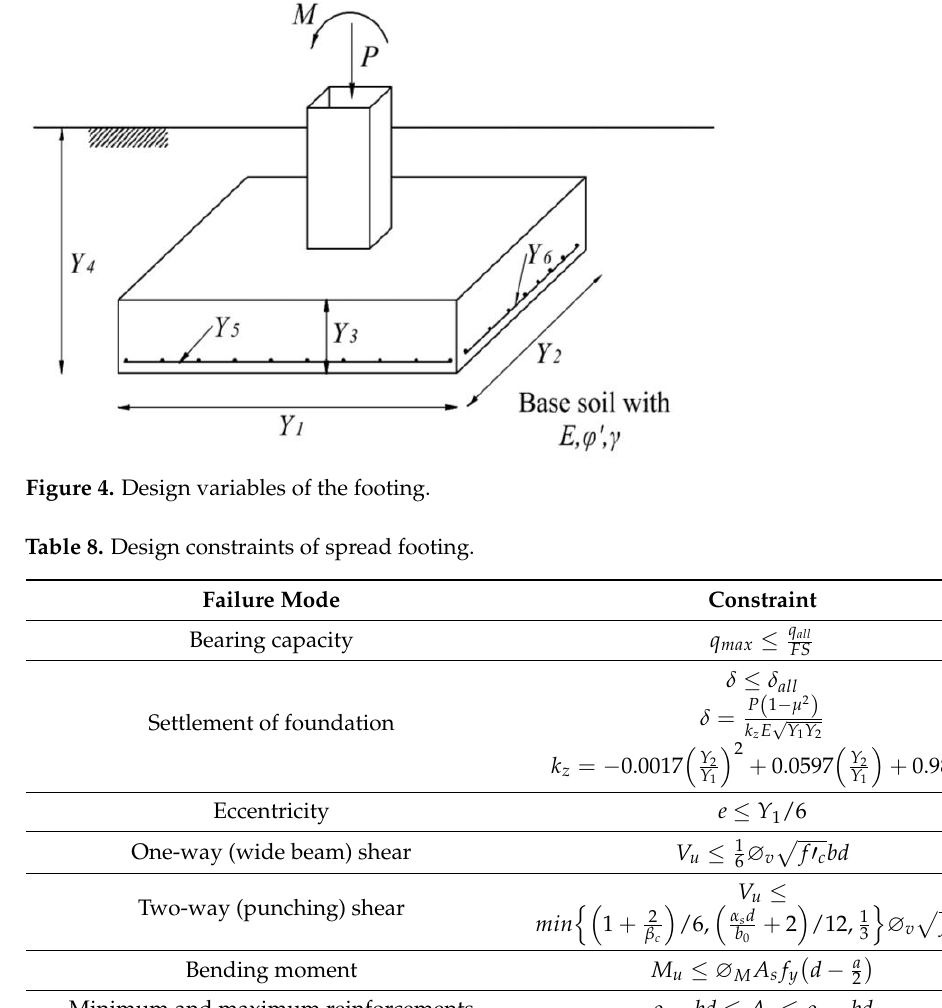
Table 8. Design constraints of spread footing.